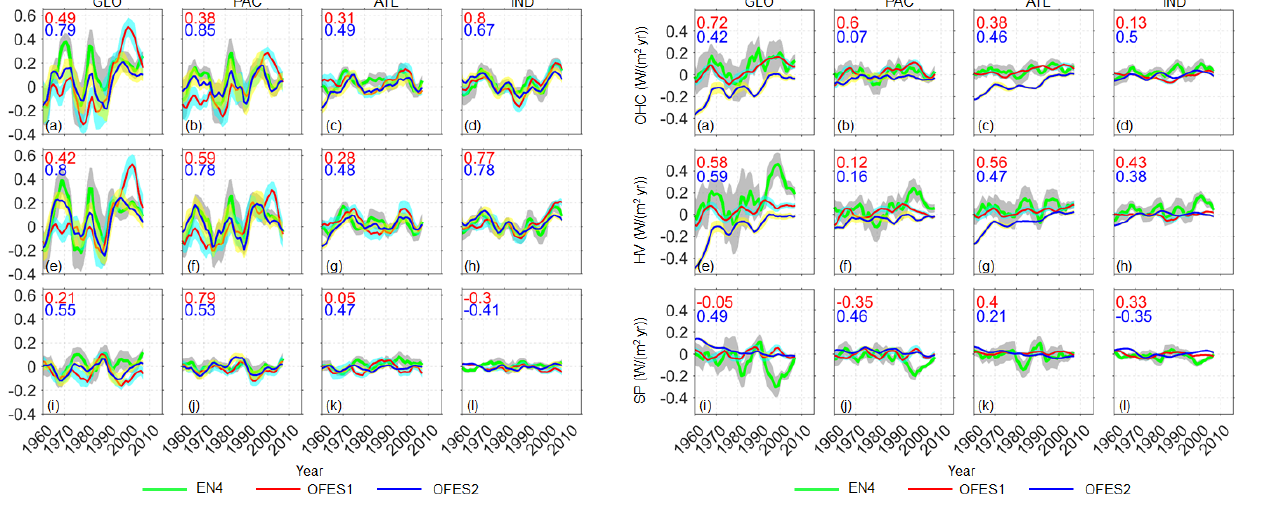
Figure 5. Temporal evolution of the 10-year rolling trends in the global and basin OHC (top row), HV (middle row), and SP (bot- tom row) in the upper layer (0–300m), based on the three datasets. Numbers in the top left corners are the correlation coefficients be- tween EN4 and OFES1 (red) or OFES2 (blue). The OHC, HV, and SP were converted to accumulative heating (Wm − 2 ) over the en- tire surface of the Earth. Thick green line: EN4 (gray shadow: 95% confidence interval); solid thin red line: OFES1 (cyan shadow: 95% confidence interval); solid thin blue line: OFES2 (yellow shadow: 95% confidence interval).